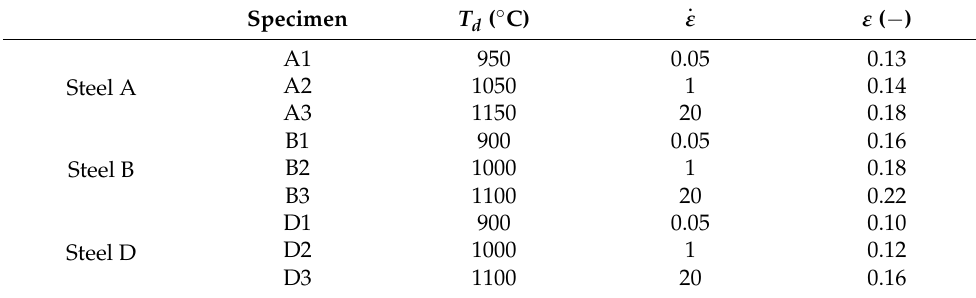
Table 7. Parameters of additional uniaxial compression tests of steels A, B and D.